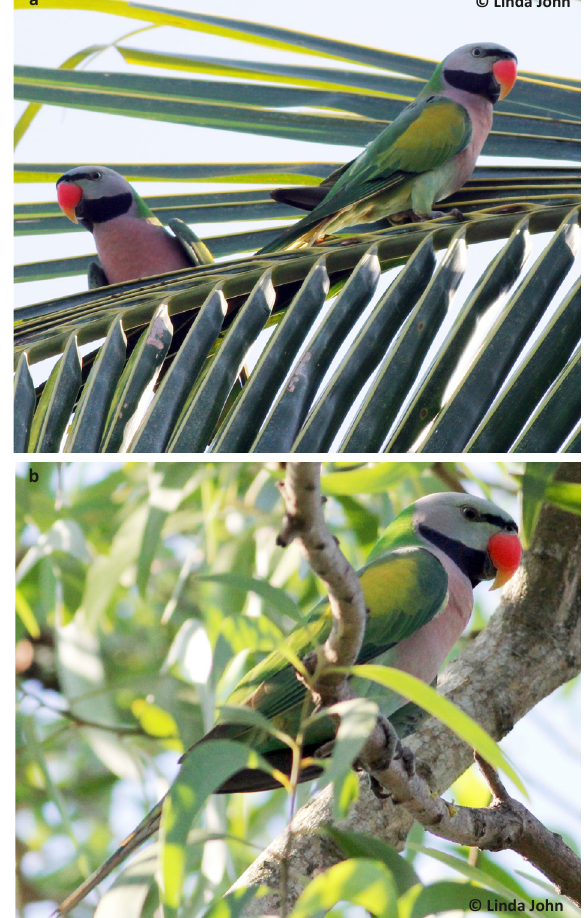
Image 2. Red-breasted Parakeet Psittacula